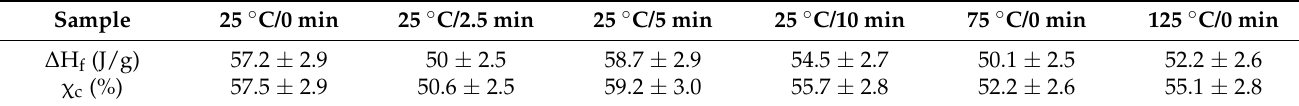
Table 3. Melting enthalpy and degree of crystallinity of different PVDF membranes.